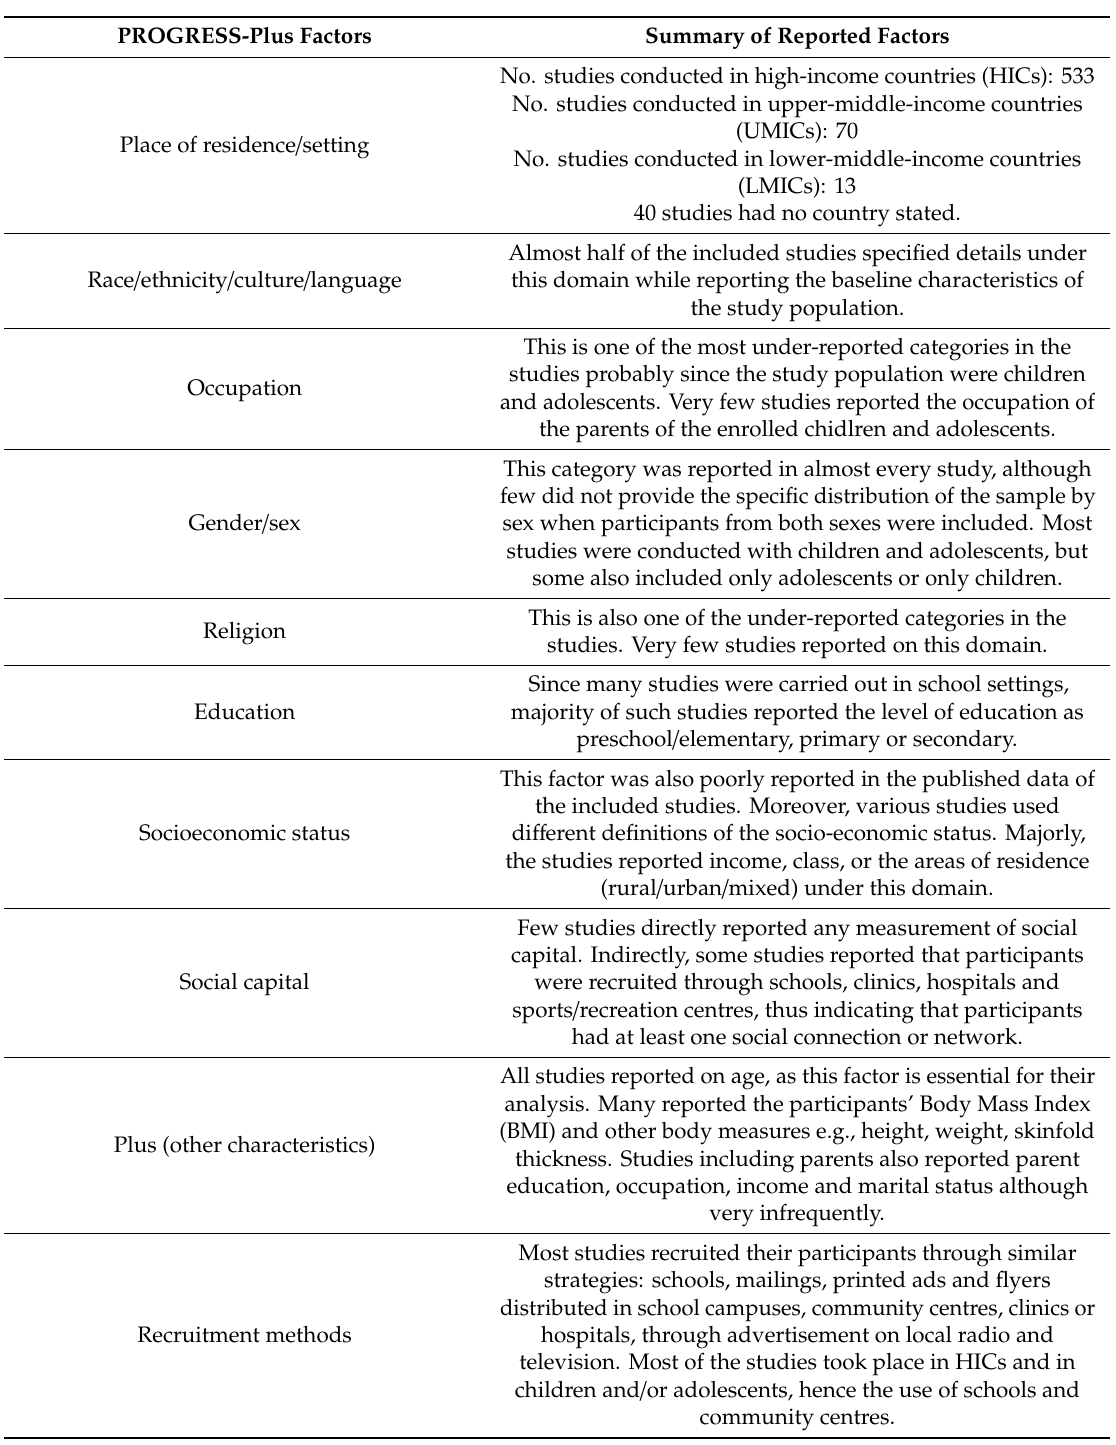
Table 1. The summary of findings from the